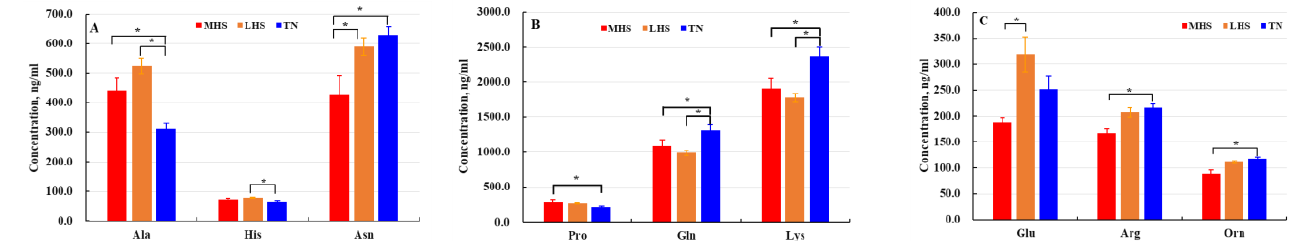
Figure 5. Concentrations of AAs in the plasma of yaks raised under TN, LHS, and MHS conditions. * p < 0.05. TN = Thermal-neutral, LHS = Light heat stress, and MHS = Medium heat stress. ( A – C ) Concentrations of AAs were validated with targeted metabolomics. Table 7. Validated plasma metabolites associated with the adaptation to HS, µ